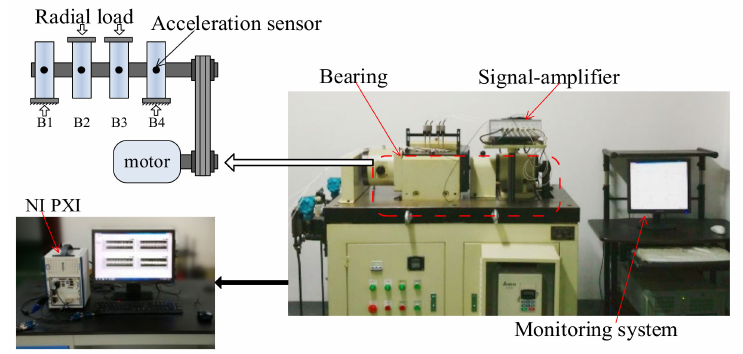
Figure 13. Experimental